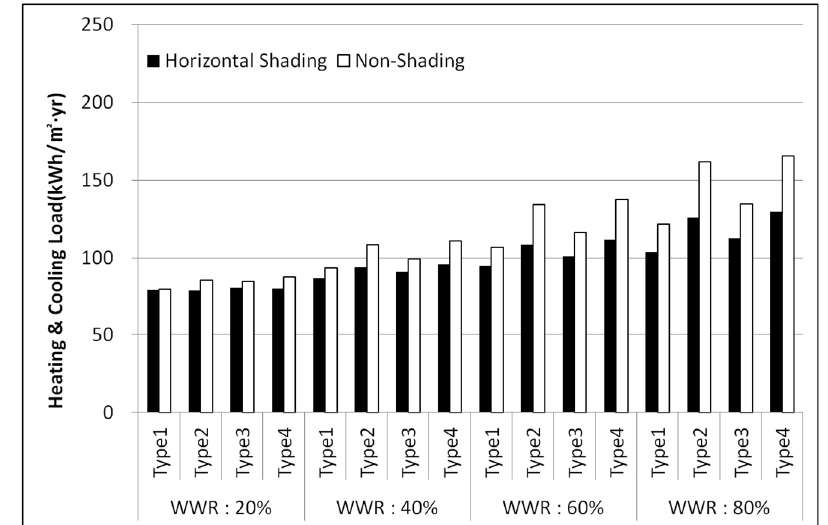
Figure 5. Variation of the heating & cooling load according to the shading installation (south façade).